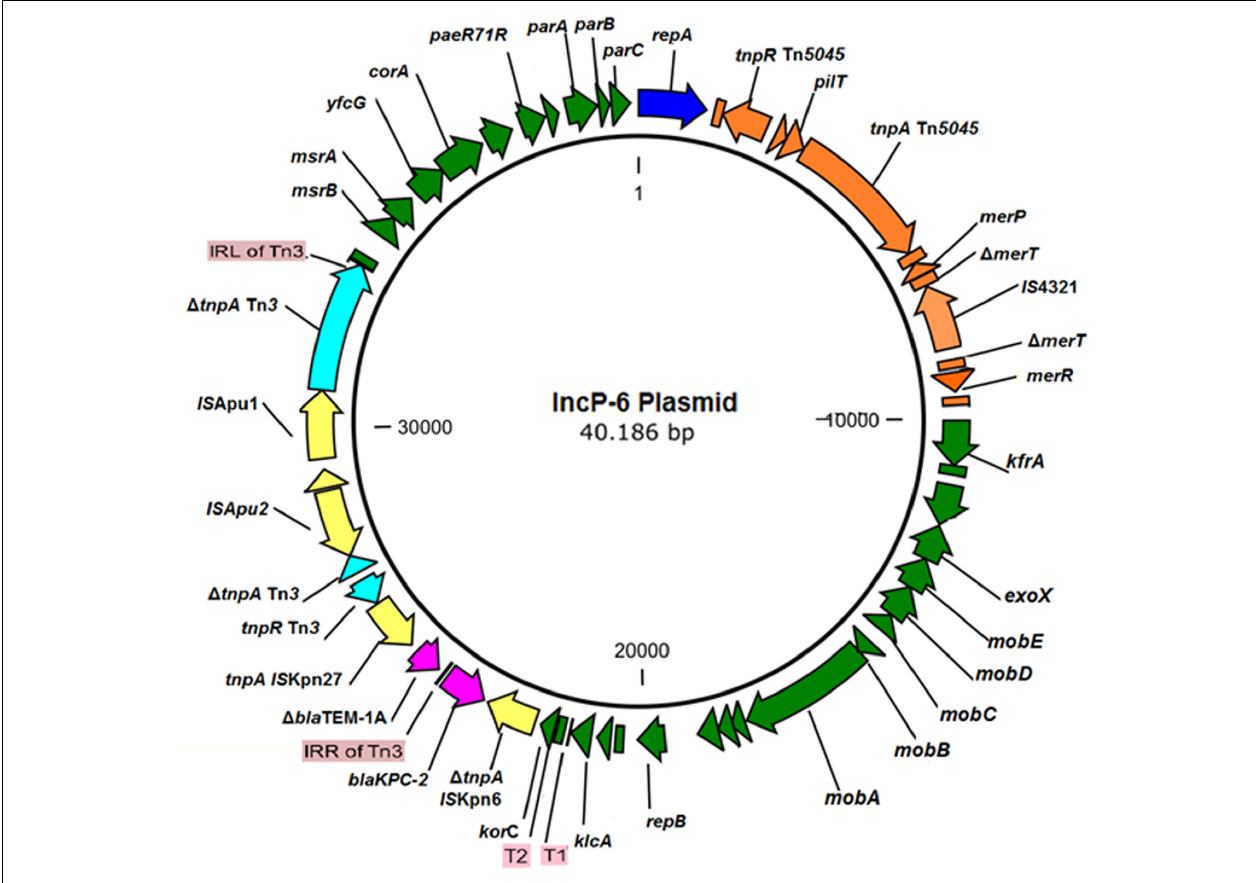
FIGURE 1 | Genetic Map of the p121SC21-KPC2. The backbone of the plasmid contains one region responsible for mobilization and another for replication and maintenance (both indicated in dark green). The gene bla KPC - 2 (fucsia arrow) is located upstream of an interrupted bla TEM - 1 gene and flanked by IS Kpn6 and IS Kpn27 . It is adjacent to a Tn 3 transposon with an IS Apu -mediated interrupted